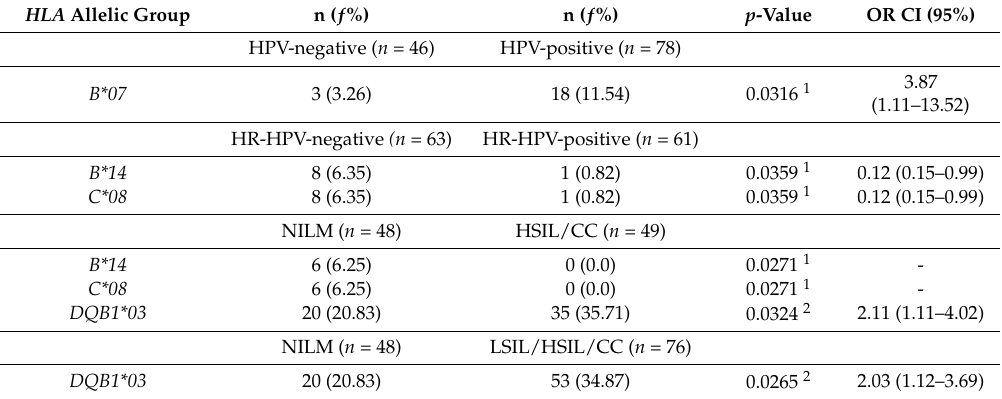
Associations of HLA allelic groups with risk of HPV infection or cervical lesions/cancer